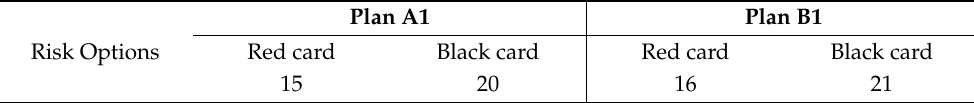
Table 3. Test Games.